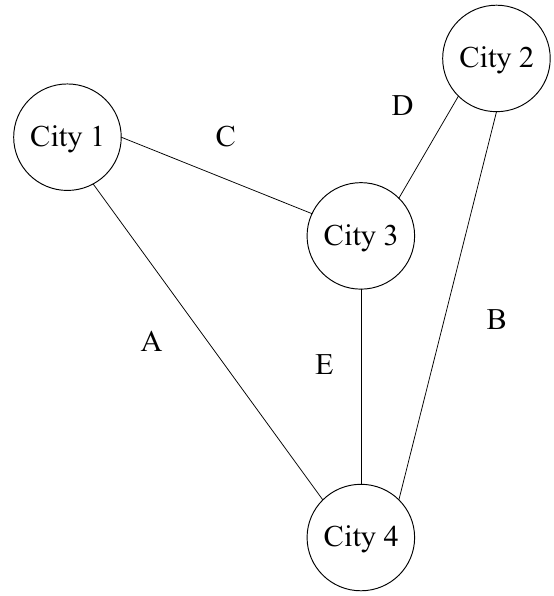
Figure 1. Example network for vehicle in platooning.